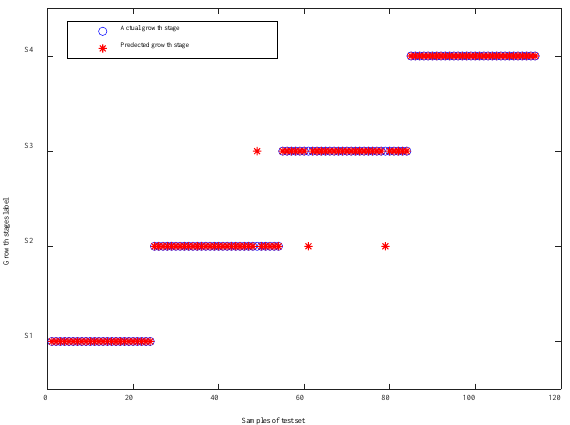
Figure 11. Comparison chart between the actual growth stage and identification results of the test